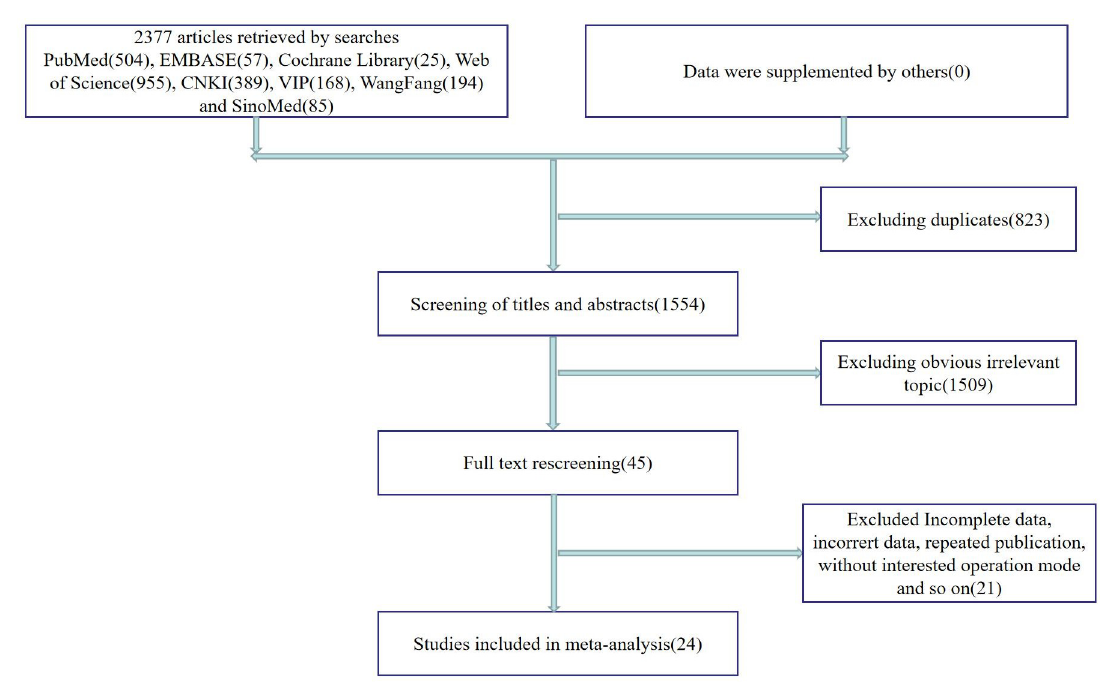
Fig 1. The specific screening process of this